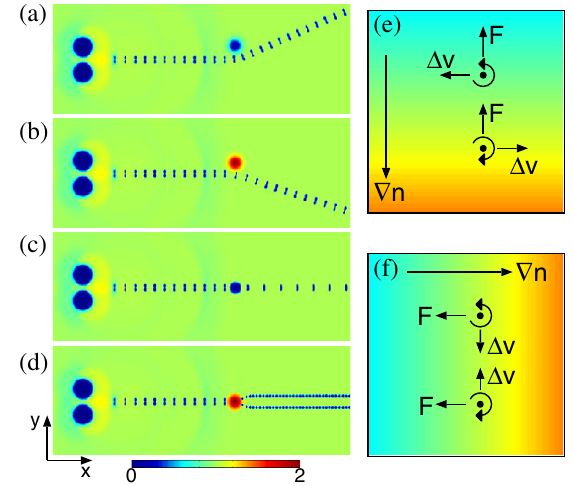
FIG. 9. Stroboscopic images of the density profile j c j 2 =n in 0 the rest frame. A vortex dipole is launched by the two Gaussian Þ ¼ 5 , d=(cid:2) ¼ 4 : 5 , and = ð gn potentials as in Fig. 6 with V 0 0 D=(cid:2) ¼ 19 . The stroboscopic images are taken at time intervals ¼ 20 . (a) A Gaussian potential with V Þ ¼ 1 and = ð gn of (cid:3) t=t 0 0 0 d=(cid:2) ¼ 4 : 5 is located at y ¼ 1 : 6 . (b) A Gaussian potential with Þ ¼ (cid:2) 1 and d=(cid:2) ¼ 4 : 5 is located at y ¼ 1 : 6 . (c) A = ð gn V 0 0 Þ ¼ 1 and d=(cid:2) ¼ 4 : 5 is = ð gn Gaussian potential with V 0 0 ¼ 330 . (d) A Gaussian potential with switched on at t=t 0 Þ ¼ (cid:2) 1 and d=(cid:2) ¼ 4 : 5 is switched on at t=t ¼ 330 . = ð gn V 0 0 0 The field of view of each panel is 224 (cid:2) (cid:5) 80 (cid:2) . (See also Supplemental Material [31].) (e), (f) Schematic illustrations for explaining the Magnus